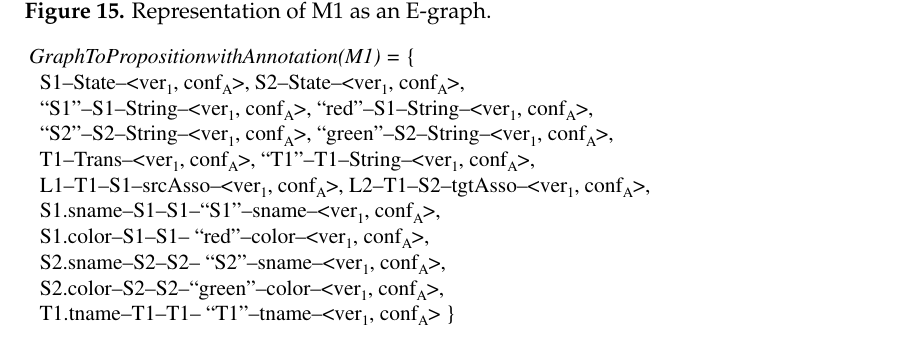
Figure 16. Propositional encoding of M1.